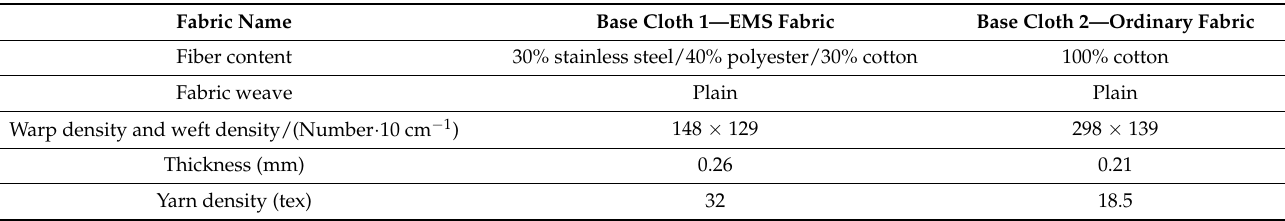
Table 1. Parameters of fabric samples.